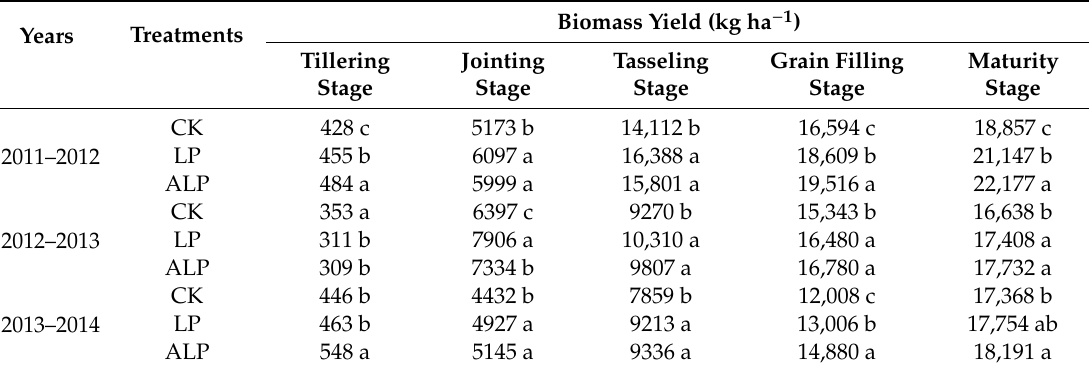
Table 4. E ff ects of di ff erent straw incorporation treatments on biomass yield at di ff erent growth stages of winter